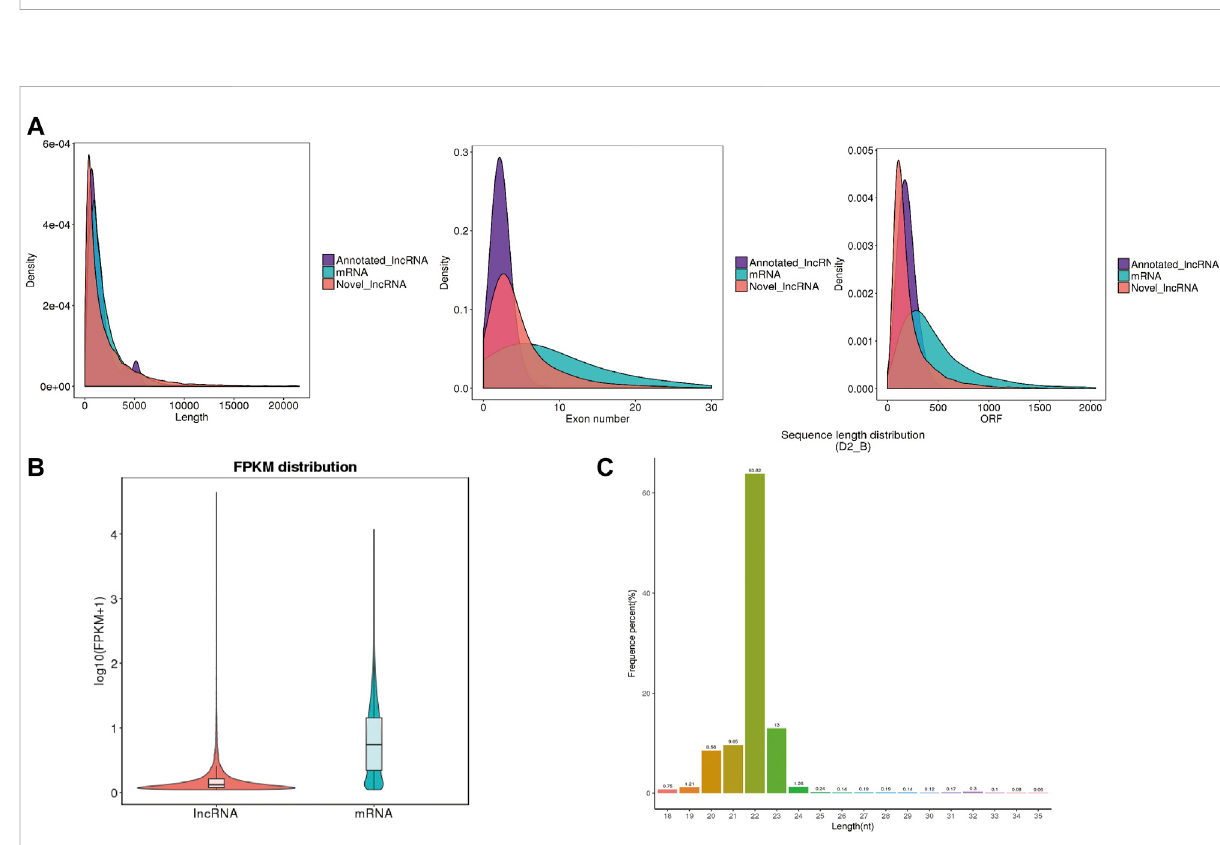
GenomicarchitectureandexpressionlevelofIncRNAsandmiRNAs. (A) ComparisonofmRNAtranscriptlength,exonnumberandopenreading frame (ORF) length. (B) Expression level of IncRNAs and mRNAs, calculated as log10(FPKM+1). (C) Length distribution of all identi fi ed small